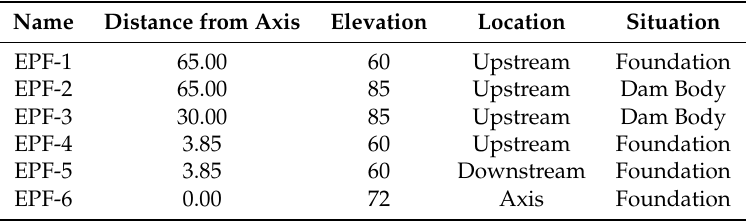
Table 3. Characteristics of Vibrating Wire Piezometer installed in Section #2 of Boostan